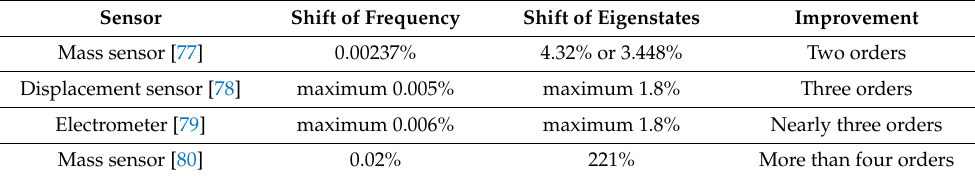
Table 3. Comparisons of properties of different EL-SCRB sensors with two resonators.